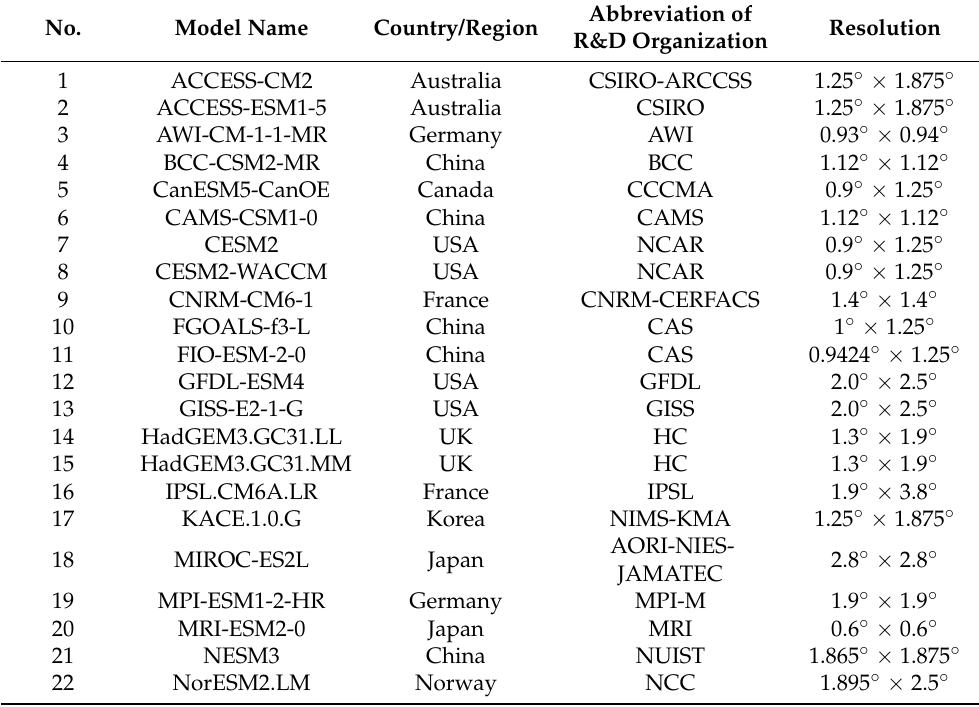
Table 3. Basic information of the Earth–climate system models in